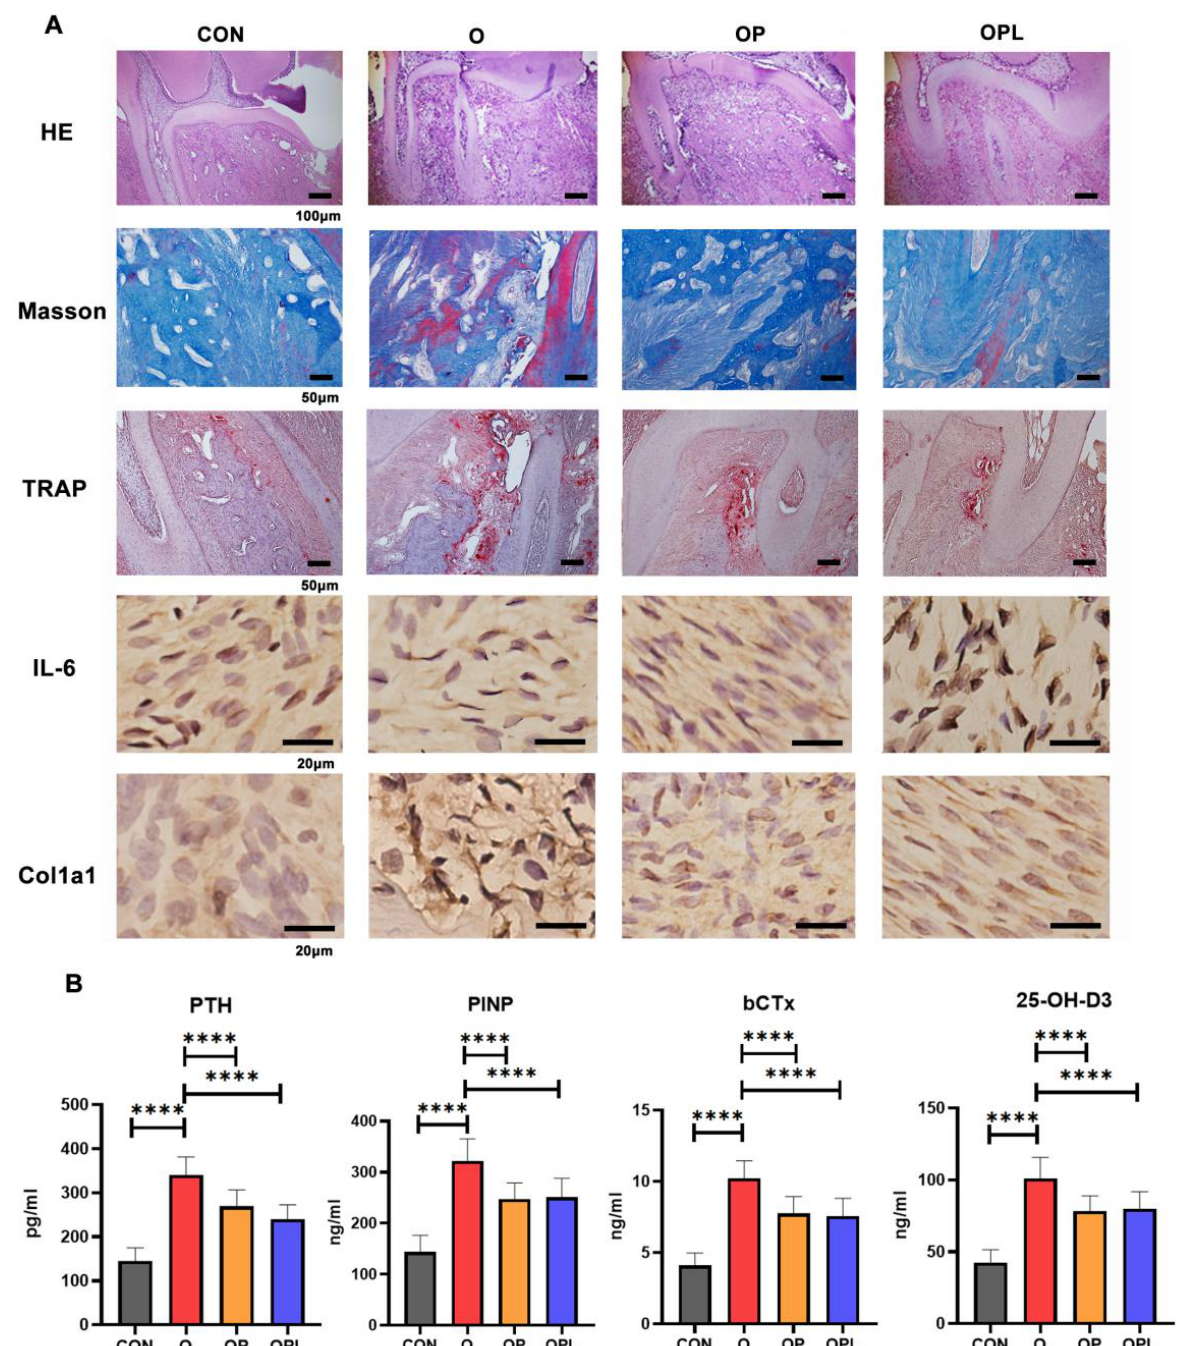
Figure 3. Comparison of the periodontal microenvironments of orthodontically mobile teeth in each experimental group: ( A ) representative images of H&E (scale bar = 100 µ m), Masson, and trap staining (scale bar = 50 µ m) methods and expression levels of immunohistochemical osteogenic and inflammatory markers (scale bar = 100 µ m) in the periodontal region of orthodontically mobile teeth; ( B ) expression of bone metabolic markers. Values are presented as means ± SD. Note: **** p < 0.0001; n =